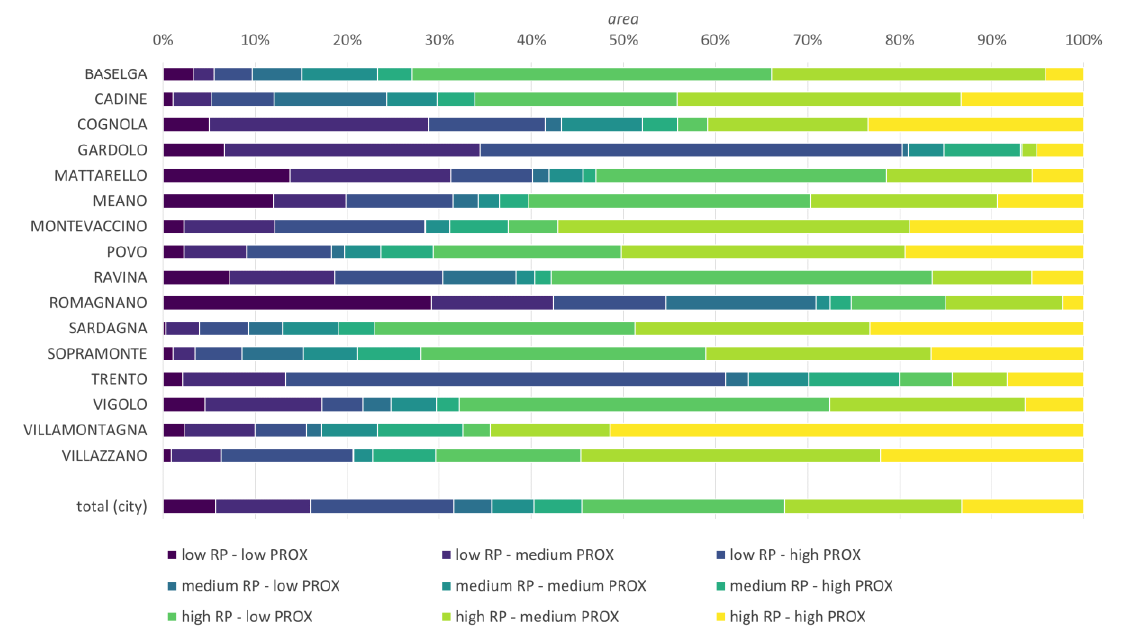
Figure 7. Percentage of district area classified in each class of ROS.